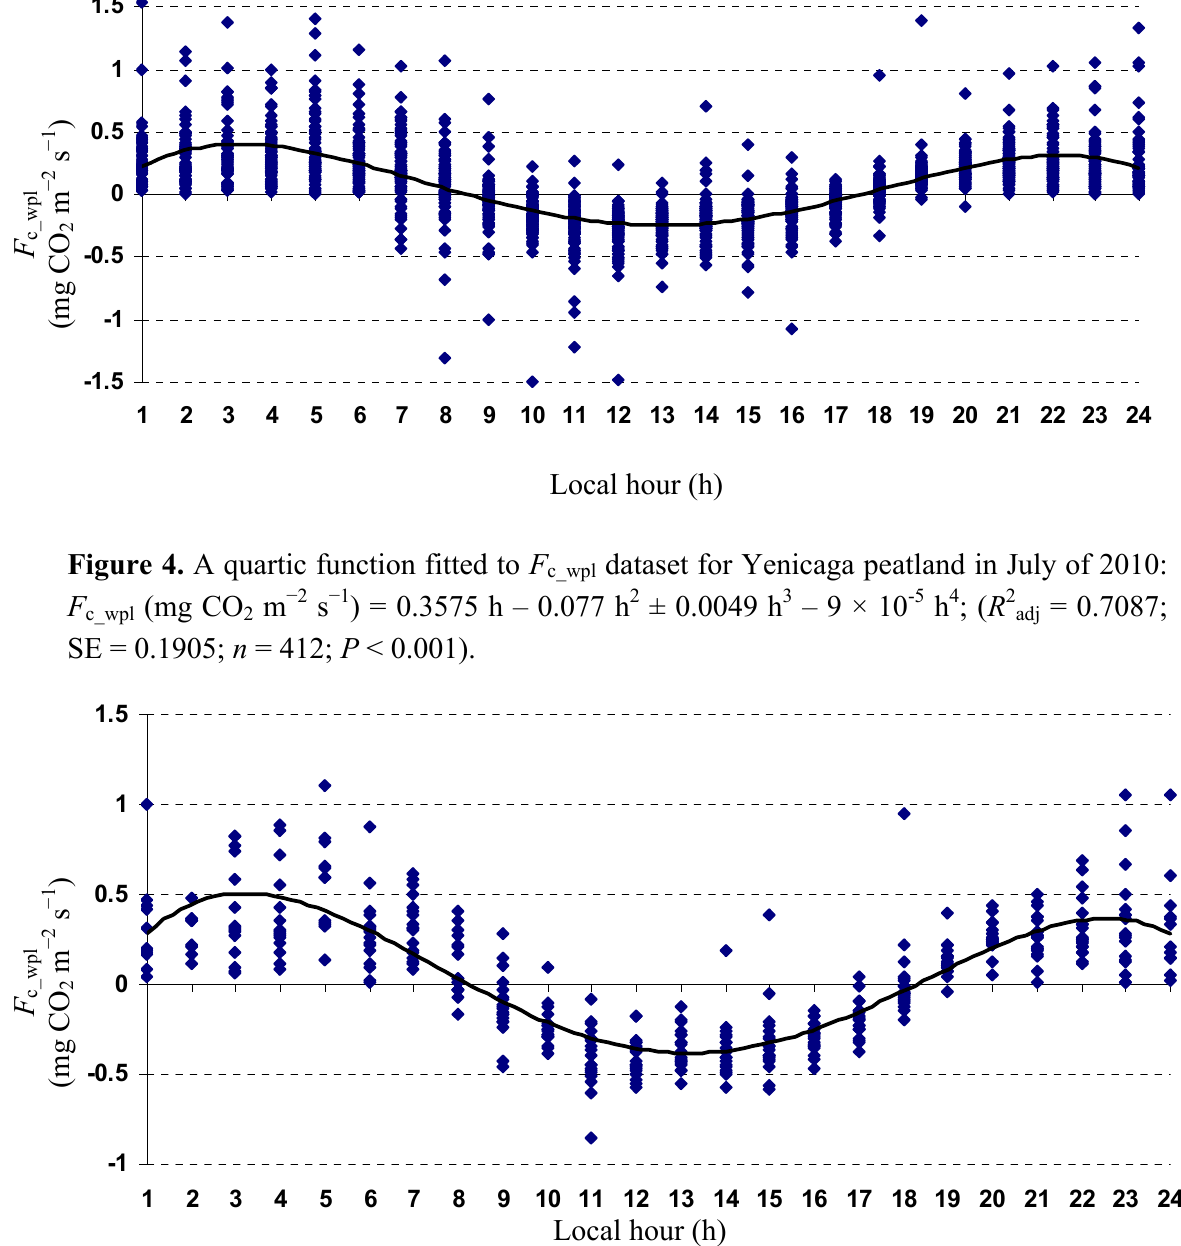
dataset in the Yenicaga peatland for c_wpl (mg CO m − 2 s − 1 ) = 0.2807 h − 0.0602 h 2 c_wpl 2